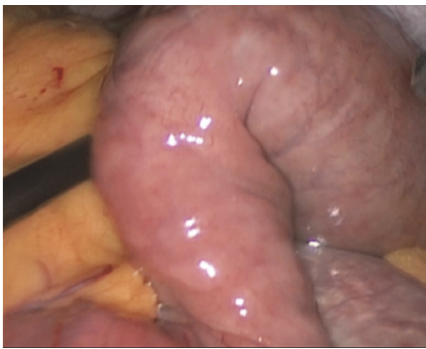
Figure 1: Transition zone in mid jejunum.